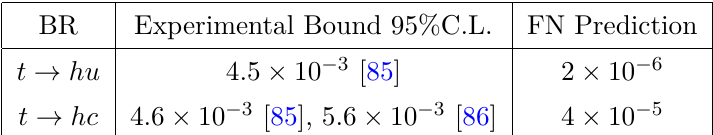
Table 13 . Branching ratios for the flavour changing top decays. In the second column we report the experimental upper bounds, while in the third column the FN predictions. The cut-off scale is fixed to Λ q = 1 TeV and all the O (1) parameters are taken equal to 1 .